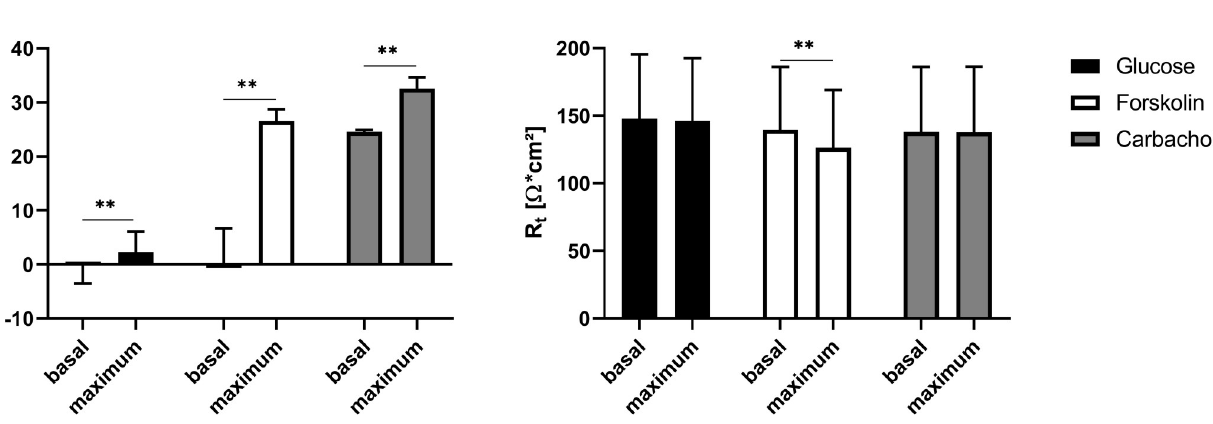
PLOS ONE | https://doi.org/10.1371/journal.pone.0256143 August 23,